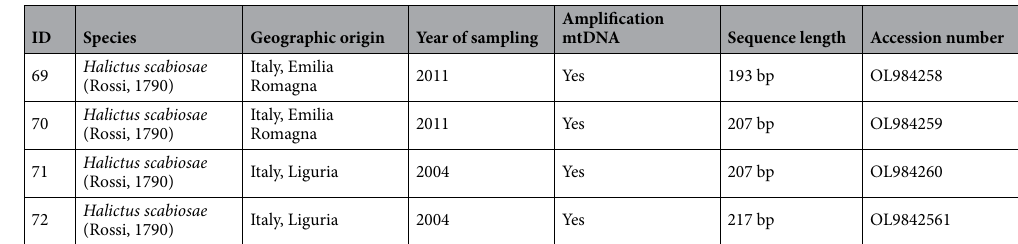
Table 1. Details of bee individuals analyzed in this investigation. nd not detected, na not available.